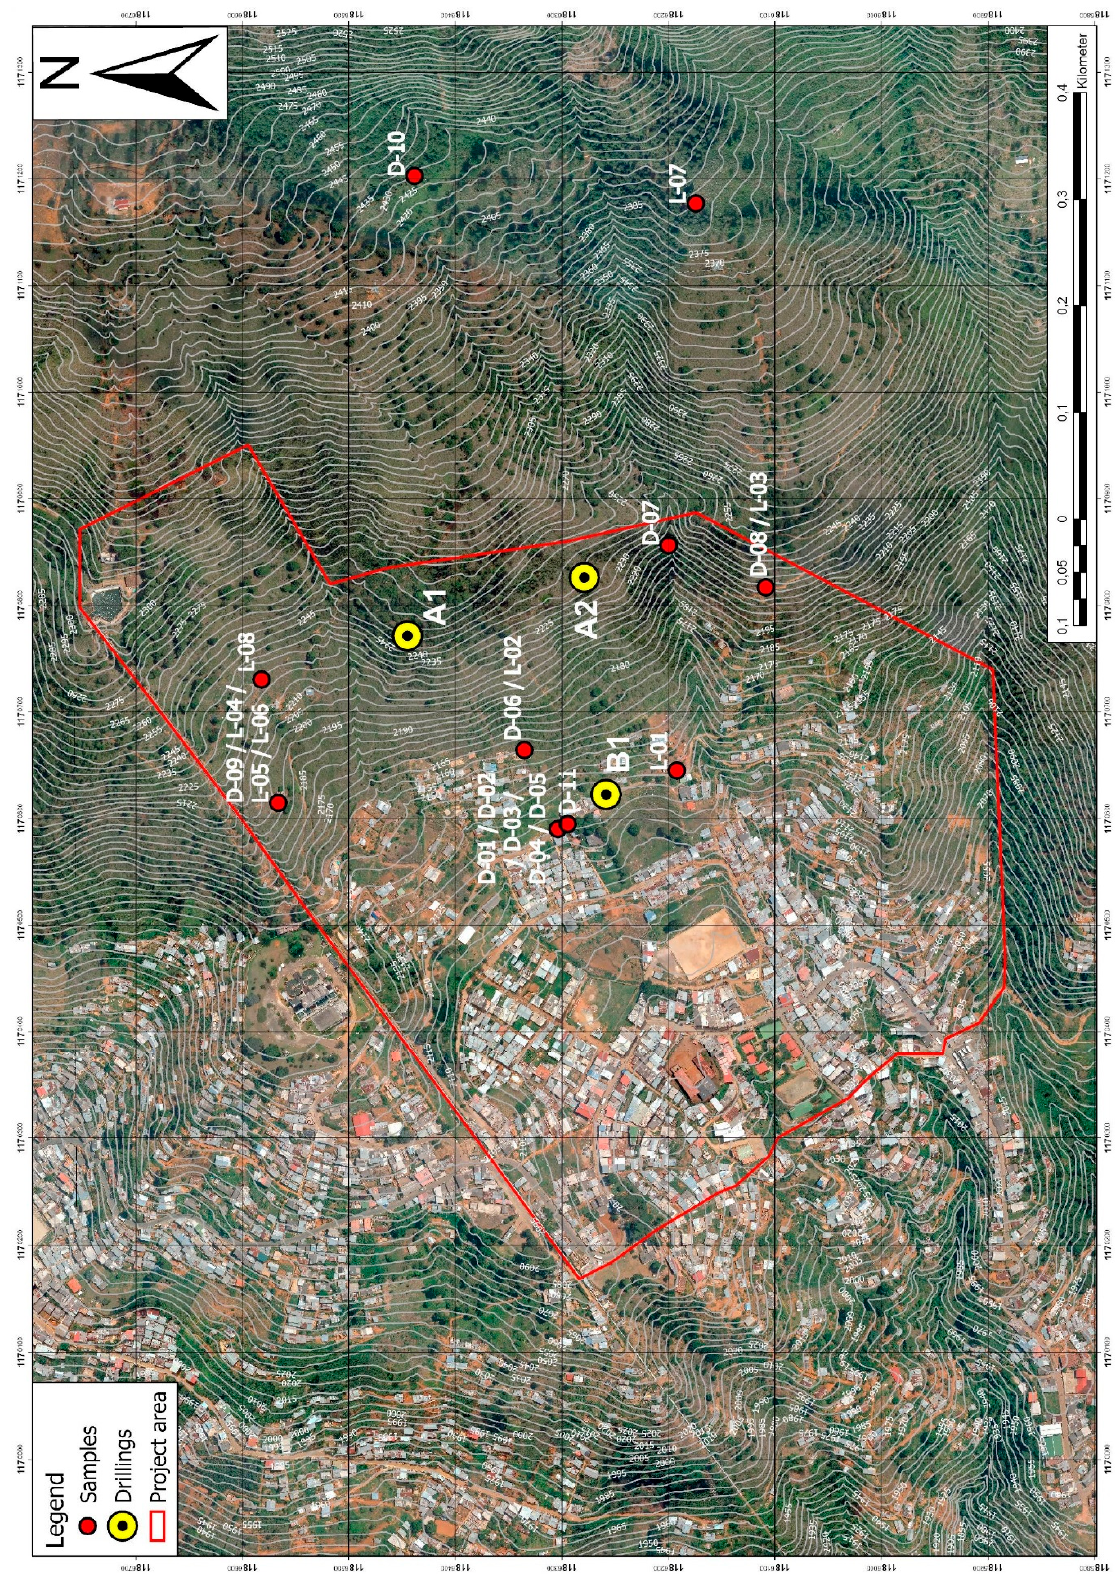
Figure 3. Map of the study site depicting the locations of the drilling and the sample locations (projected coordinate system: MAGNA Medellin Antioquia 2010).